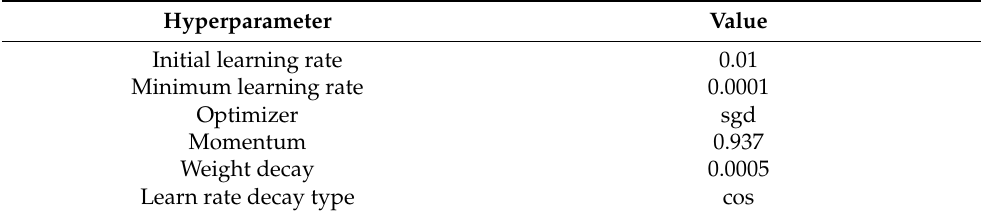
Table 3. The primary hyperparameters of the model training